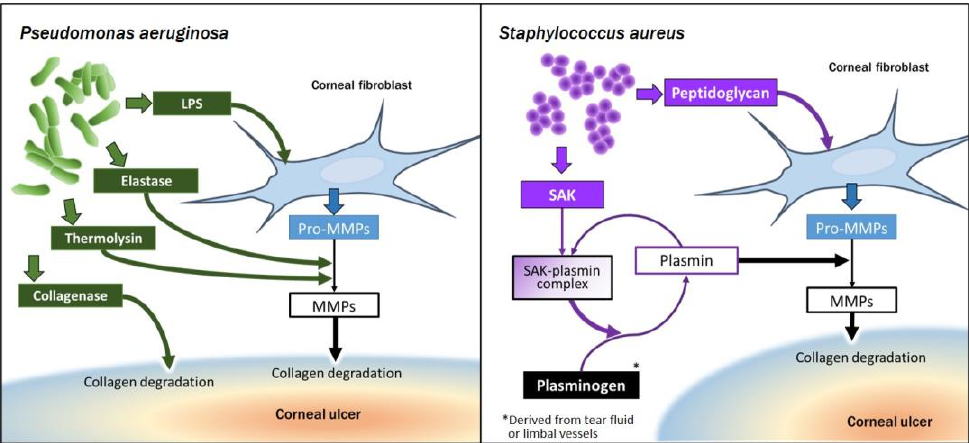
Figure 2. Pathways by which infection with Pseudomonas aeruginosa or Staphylococcus aureus promotes collagen degradation mediated by corneal fibroblasts. LPS: lipopolysaccharide; MMP: matrix metalloproteinase; SAK: staphylokinase.